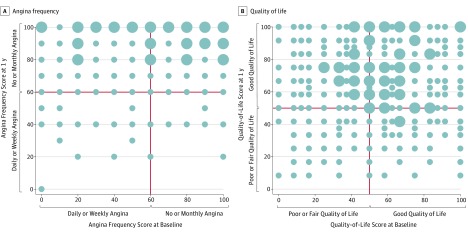
Angina Frequency and Quality of LifeScatterplots of Seattle Angina Questionnaire Angina Frequency score (A) and Quality-of-Life score (B) at baseline hospitalization and at 1 year after percutaneous coronary intervention. The size of the dot indicates the number of patients, with smaller dots indicating fewer than 16 patients and larger dots indicating 16 or more patients.